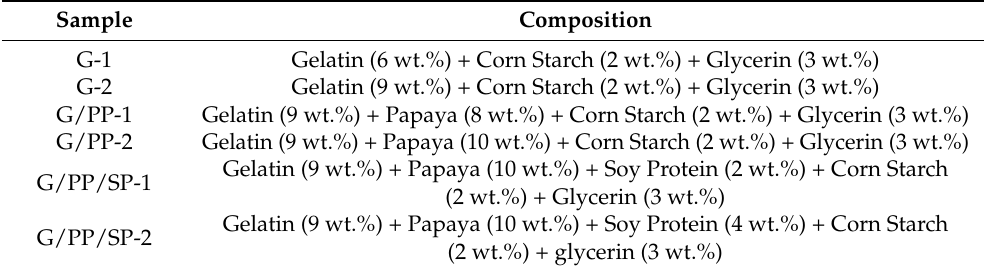
Table 1. Composition of samples along with the sample identification acronyms.